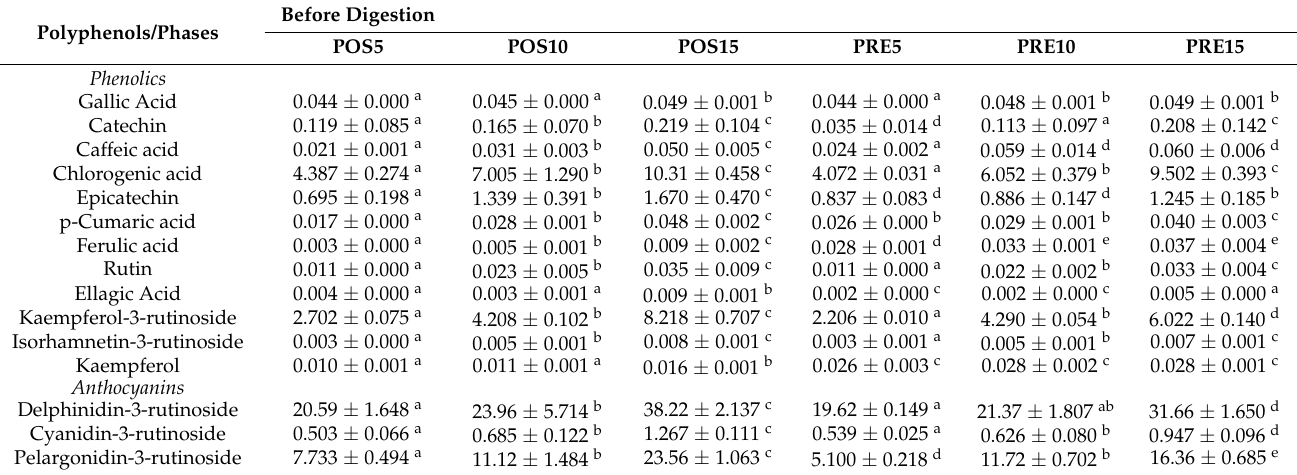
Table 3. Concentrations (mg/100 g yoghurt) of individual polyphenol in tamarillo fortified yoghurts before in vitro digestion.